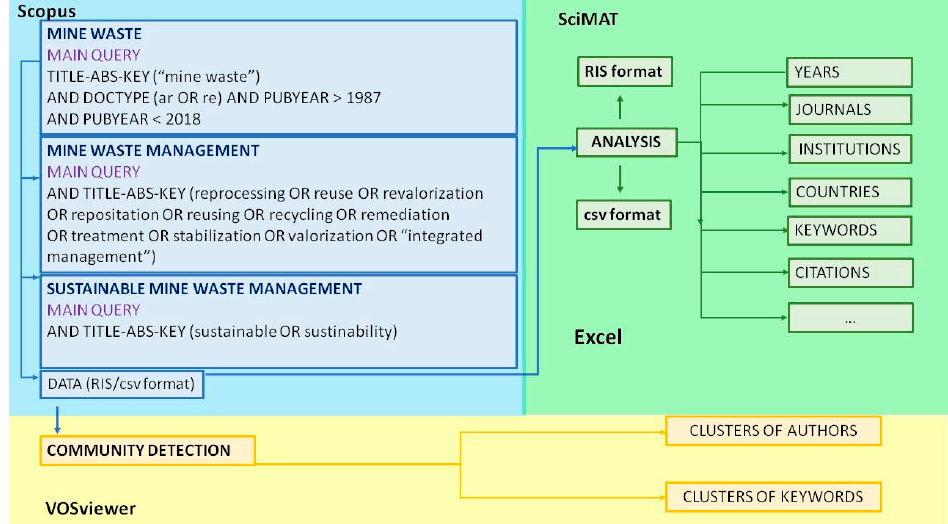
Figure 1. Methodology flow diagram.